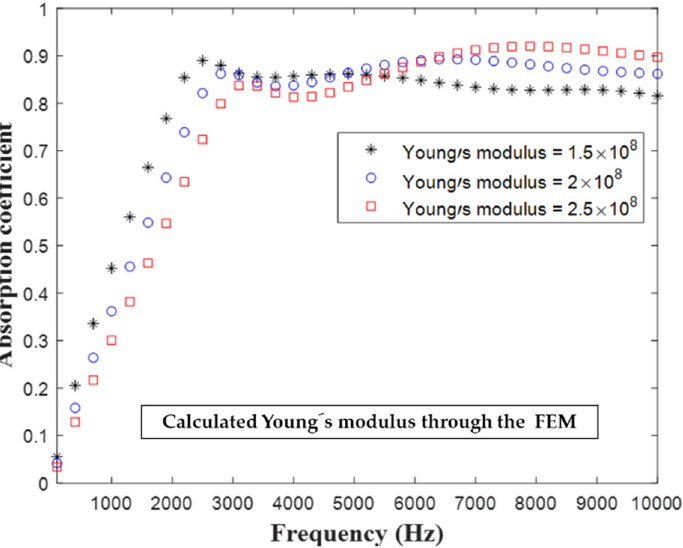
Figure 14. Influence of the real part of Young’s modulus (Unit: Pa) of the substrate of the developed metastructure on the structure’s sound absorption coefficient.